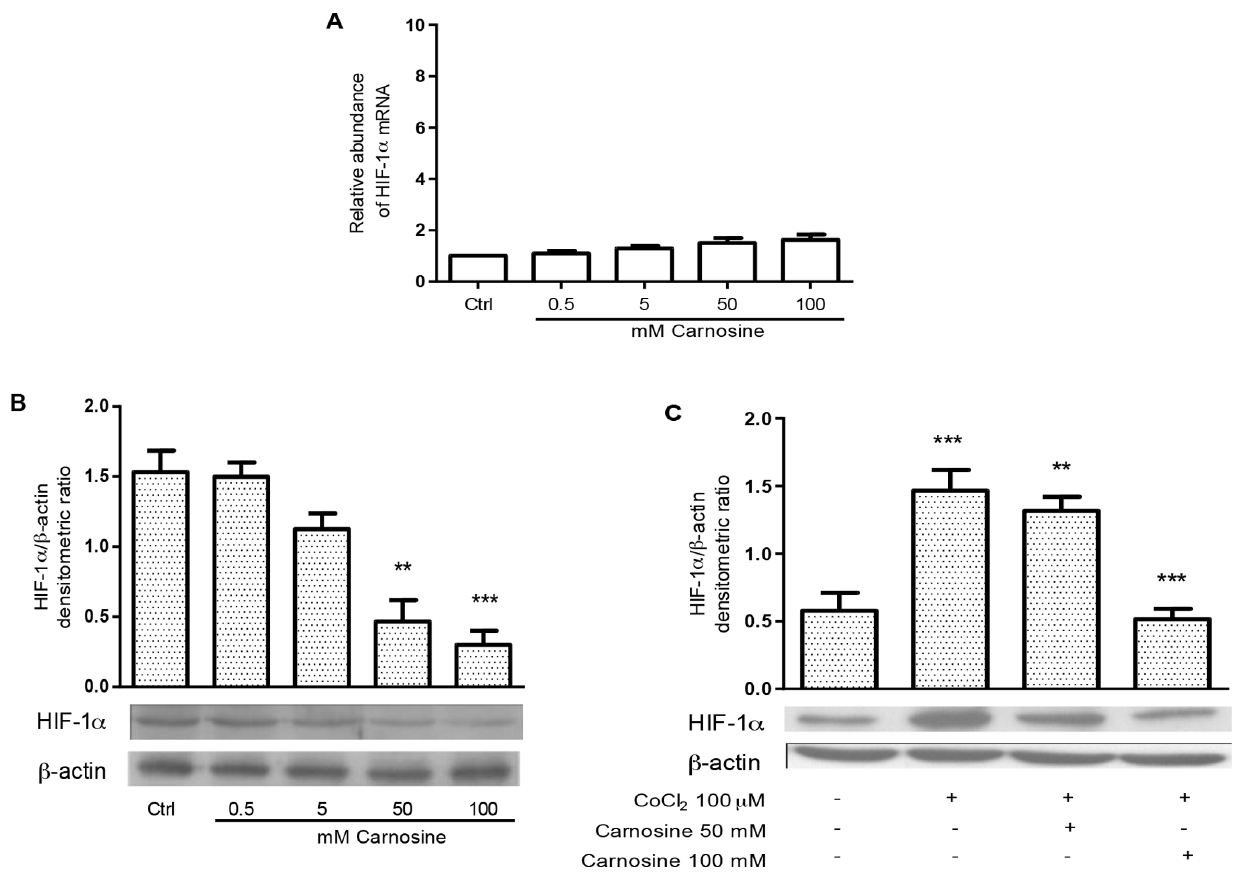
Figure 1. L-carnosine affects HIF-1 a protein expression. (A) HIF-1 a mRNAs were measured by real time PCR in a total RNA preparation from HCT-116 cells 24 h after L-carnosine treatment. White bars indicate fold changes of mRNA with respect to the amount of HIF-1 a mRNA in untreated cells reported as value 1; (B) western blotting analysis of total protein extracts from HCT-116 cells 24 h after L-carnosine and (C) L-carnosine and CoCl 2 treatment probed with HIF-1 a and b -actin antibodies. Related histograms report the densitometric values of HIF-1 a / b -actin ratio. The densitometric values represent the mean 6 SDs of three independent experiments. The differences were considered significant at **p , 0.001, ***p , 0.0001.